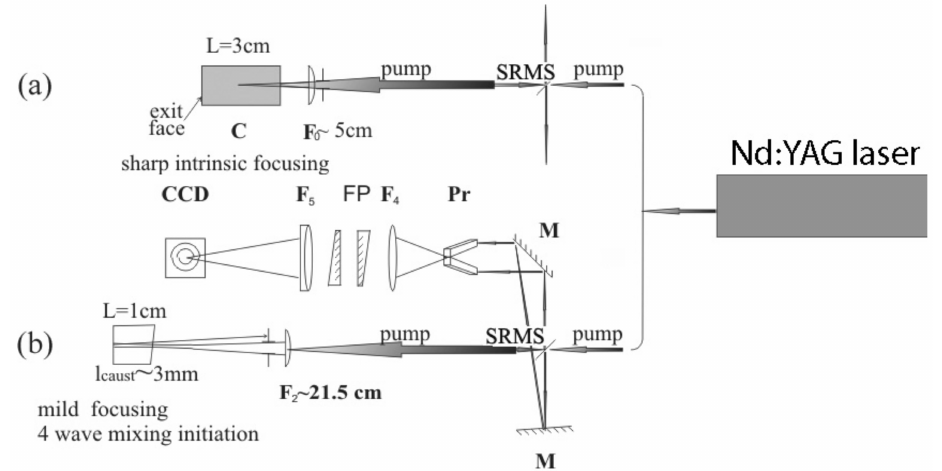
Figure 4. Experimental setup for 2PA SRMS of 100 ps pulses. There are two interaction geometry options, ( a ) sharp focusing of pump radiation into the interaction cell of 3 cm length with the lens of 5 cm focal length, and ( b ) mild focusing into short 1 cm interaction cell with the lens of 21.5 cm focal length, providing the four-wave mixing process due to the backward reflection of the pump pulse by the rear side of the cell. The upper part in ( b ) shows the scheme of Fabry–Perot spectral measurements: Pr—waveguide prism; F 4-5 —objectives transcribing the edge of the prism on the CCD matrix